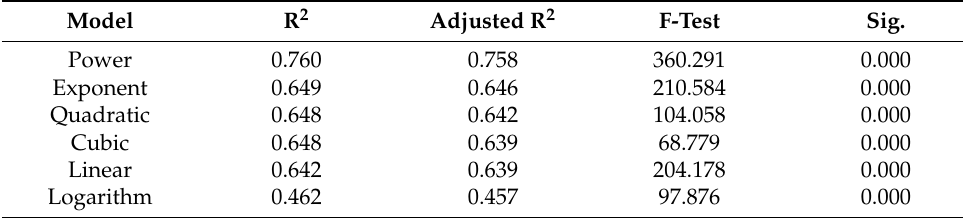
Table 3. The fitting effects and significance of the AGB and shrub crown area